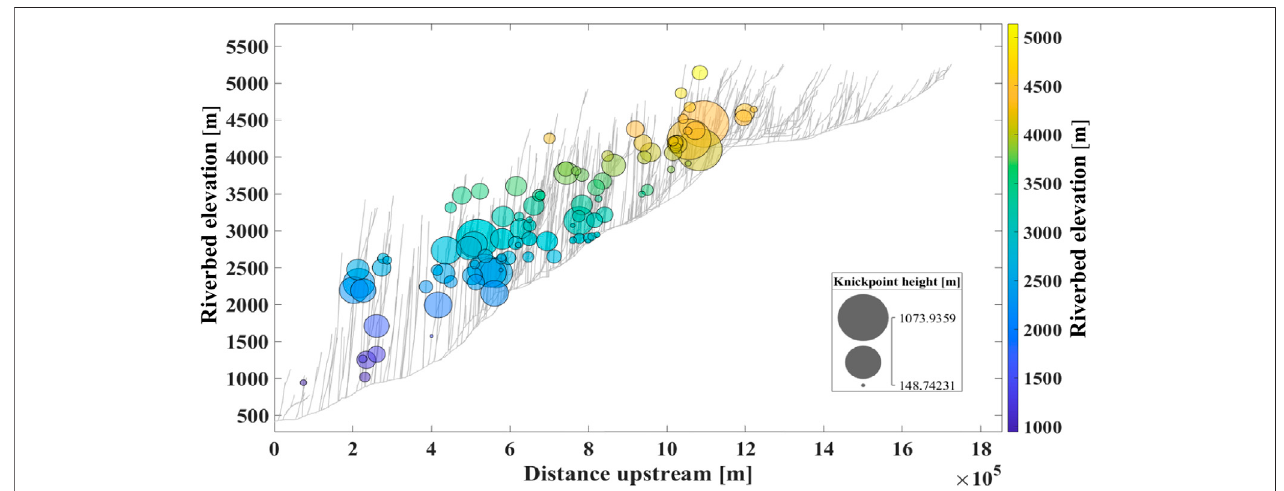
FIGURE 6 | River longitudinal pro fi le and location of river knickpoints in the upper Indus River.